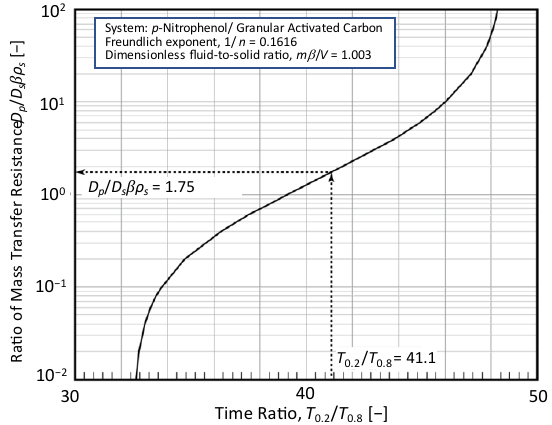
Figure 8. Relationship between R D and T 0 . 2 / T 0 . 8 values.